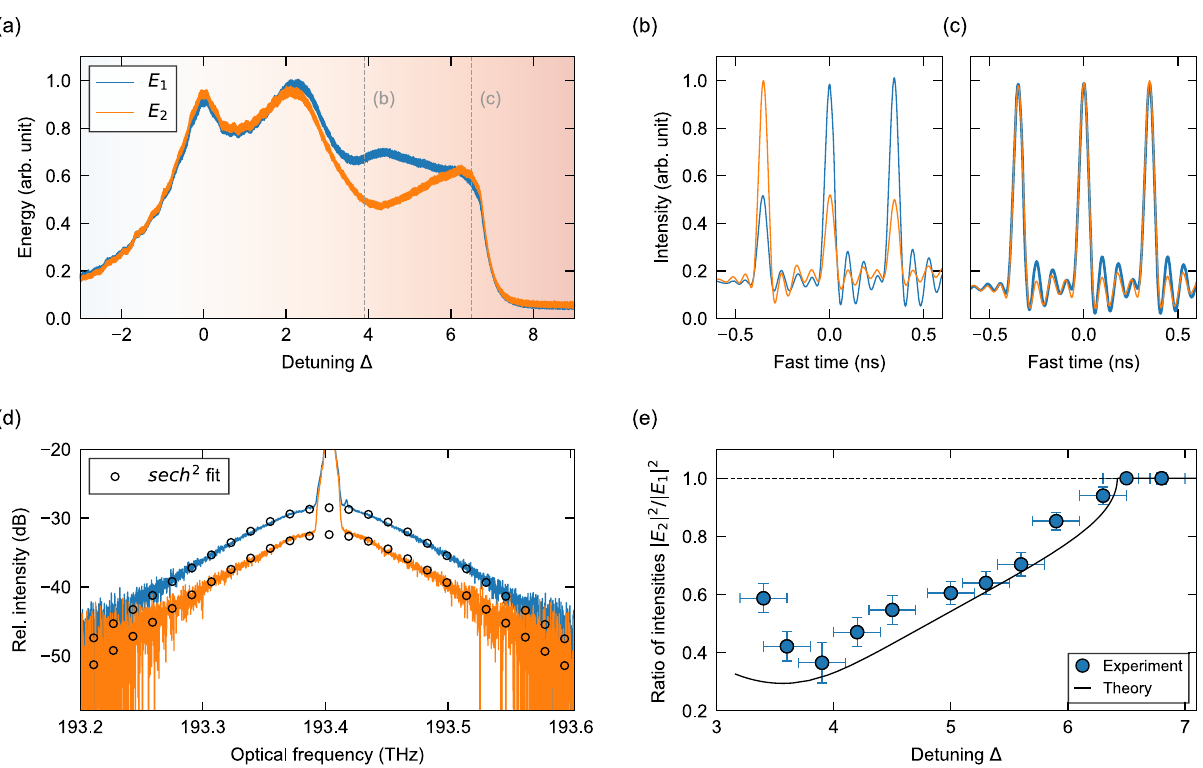
Fig. 3 Experimental observation of CS symmetry breaking. a Slow photodetector signals measured along the two cavity modes when scanning the laser frequency across a resonance. The experimental parameters are similar to the ones used to obtain the simulation results in Fig. 1: X = 4.5 and B = 1.6. b Intracavity intensity pro fi les measured with fast photodetectors (and subsequently sinc-interpolated), showing ( b ) asymmetric solitons at a detuning of Δ = 3.9 and ( c ) symmetric solitons at a detuning of Δ = 6.5. d Optical spectrum of one of the symmetry-broken CS states. The soliton is predominantly polarized along the “ blue mode ” ( E 1 ), but exhibits a small component along the orthogonal “ orange mode ” ( E 2 ). Also shown as open circles is the spectrum expected for a 2.7 ps hyperbolic secant CS. e Experimentally measured (blue solid circles) and theoretically predicted (black solid curve) ratio of the soliton intensity along the two polarization modes for a “ blue mode ” dominated CS as a function of detuning. The horizontal error bars represent an estimated ± 0.2 uncertainty in the detuning whilst the vertical error bars represent the standard deviation of multiple measurements (see Methods). The theoretical curve in ( e ) was obtained from the bifurcation data shown in Fig.